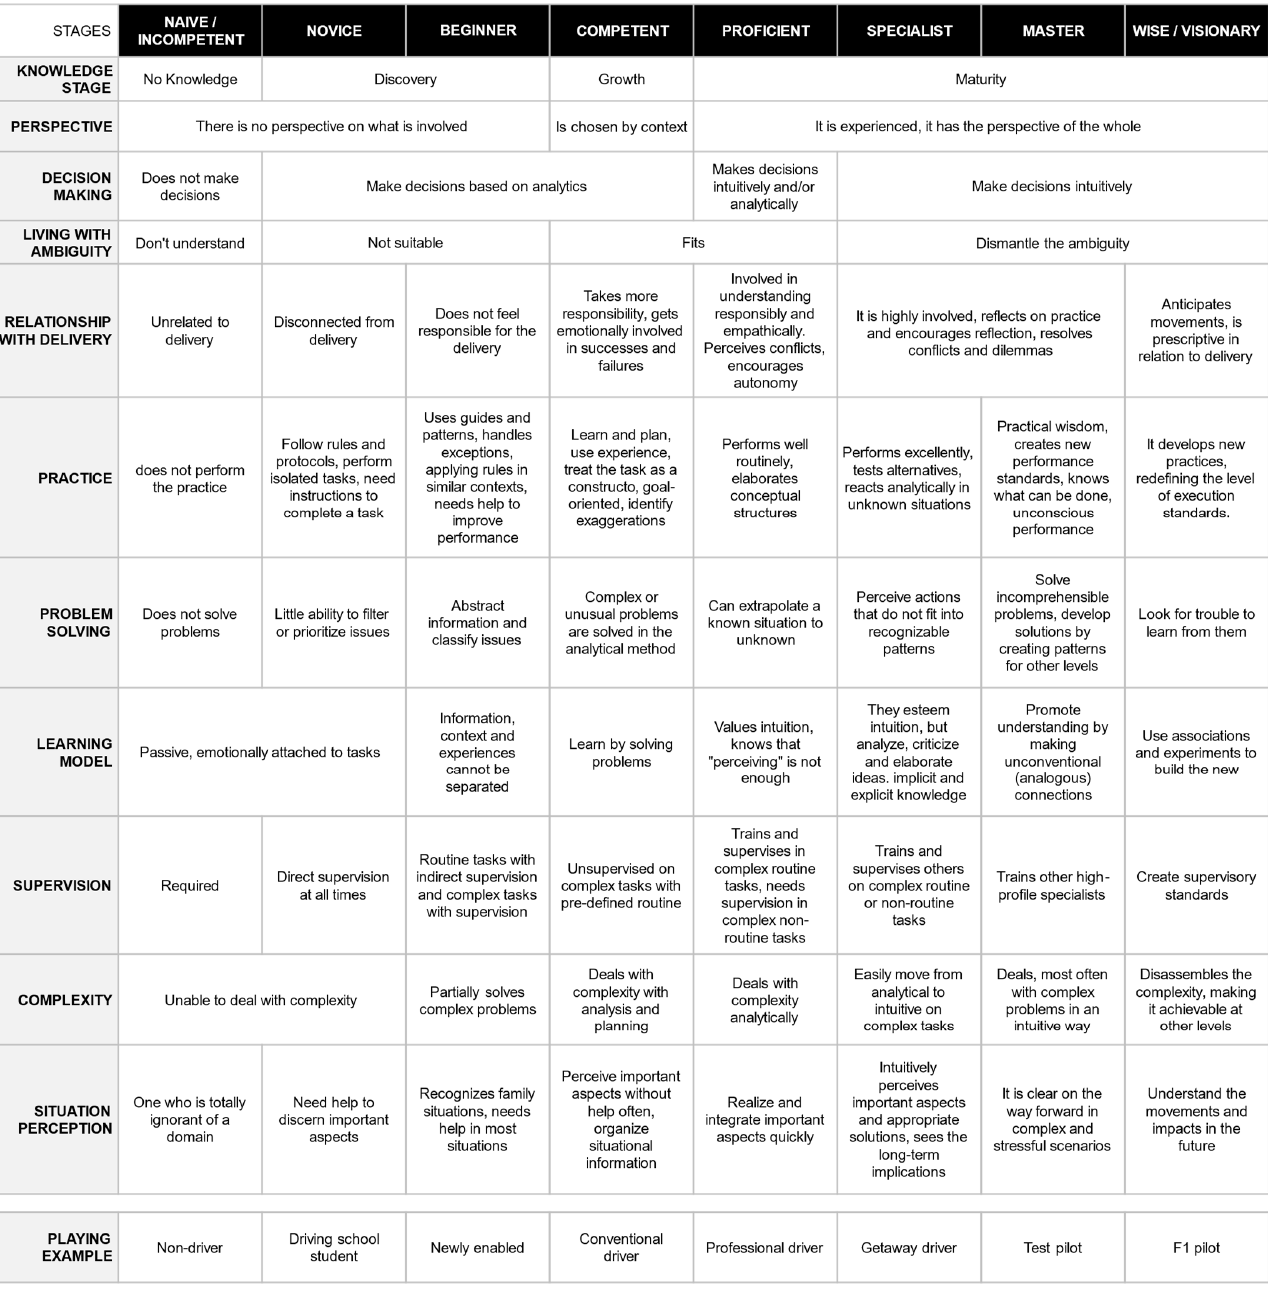
Figure 3. Consolidated matrix of the evolutions of the Dreyfus and Dreyfus (1980) Model. Source: